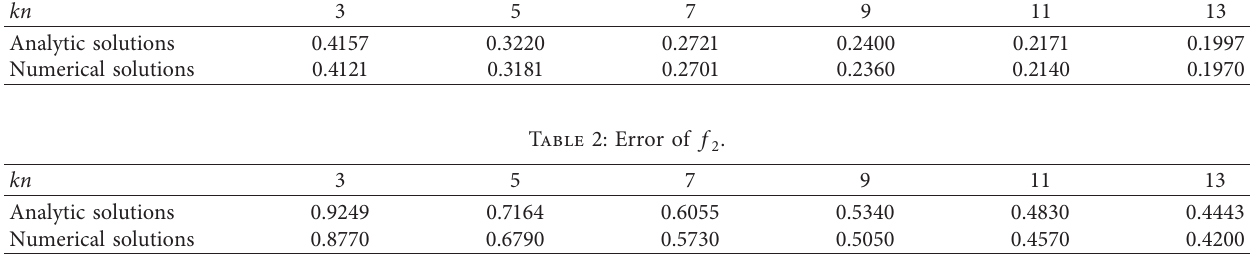
Table 1: Error of f